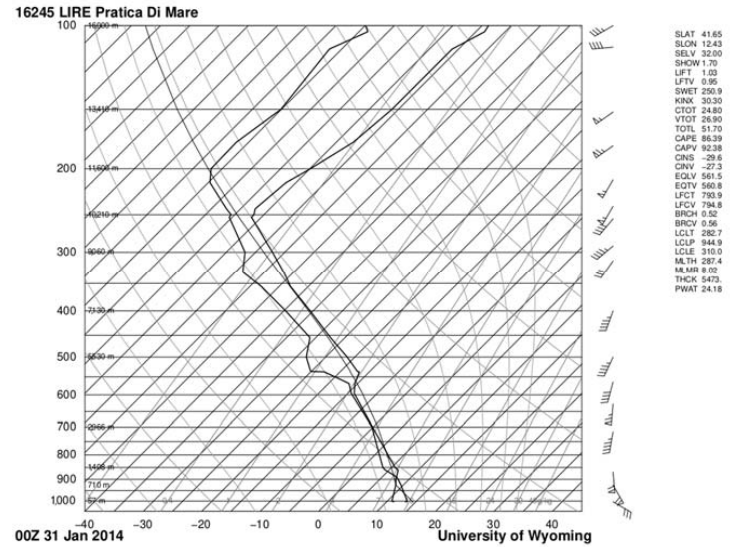
Figure 4. Skew-T diagram related to the sounding on Pratica di Mare carried out at 00 UTC on 31 January 2014. Rainfall maxima occurred along the terminal path of the Tiber River, where values of ~200 mm/48 h were recorded at the Octavia (201.8 mm/48 h) and Riano (202.0 mm/48 h) rain gauges, corresponding to a 200-year return period (Figure 5).